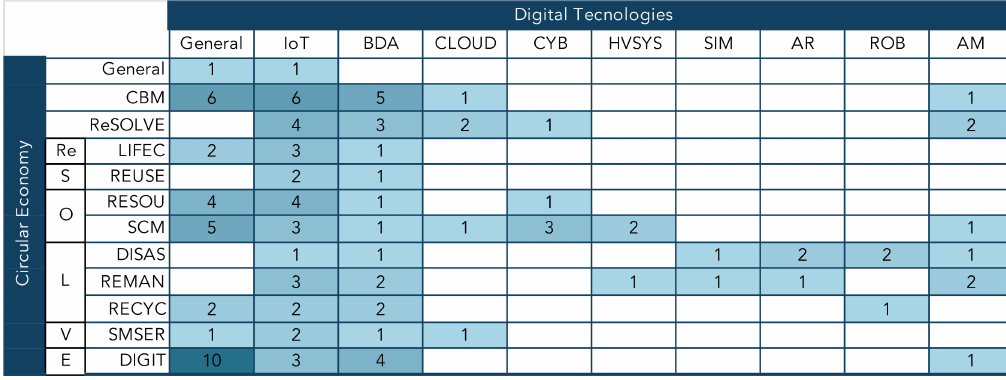
Figure 10. Heatmap of the distribution of the reviewed contributions according to CE aspects and DTs considered.